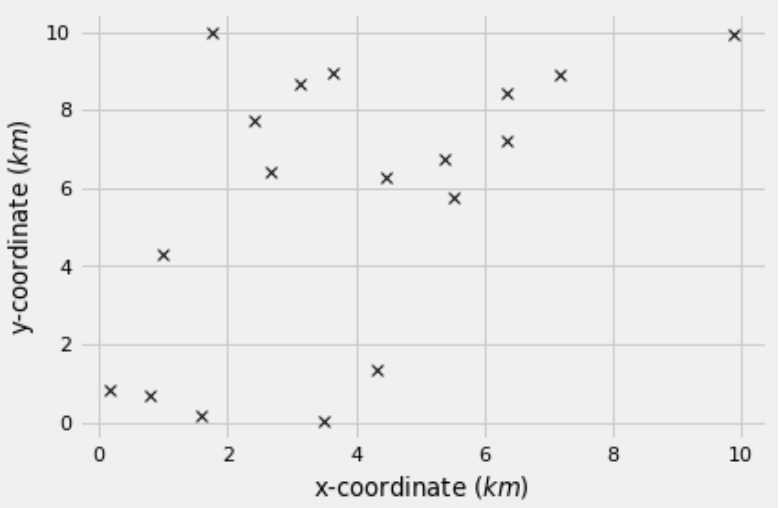
Figure 2. An example of the random distribution of Smart Meters (SMs) according to the Poisson Point Process